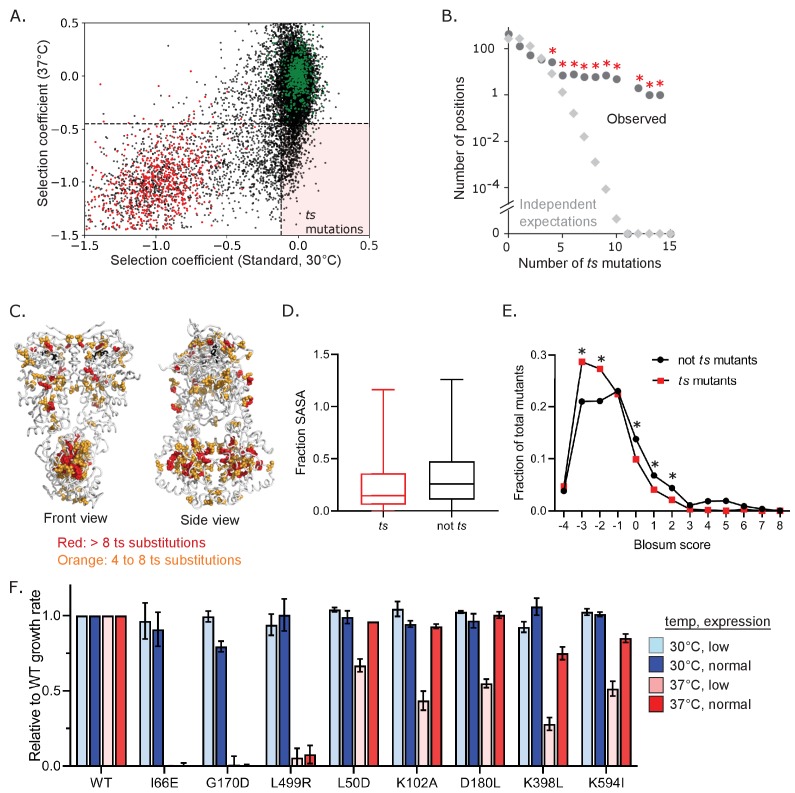
Abundance and mechanism of temperature-sensitive (ts) mutations in Hsp90.(A) Ts variants were identified that supported WT-like growth at 30°C, but were null-like at 37°C in bulk competitions. WT synonyms are shown in green and stops in red. The horizonal dashed line corresponds to y = −0.47, the upper limit of stops at 37°C and the vertical dashed line corresponds to x = −0.11, the lower limit of WT synonyms in standard conditions. The pink-shaded quadrant highlights ts mutations. All ts mutants are listed in Figure 4—source data 1. (B) Distribution of the number of observed ts mutations at the same positions of Hsp90 (●) is much greater than expected if they had occurred independently (◊). Independent expectations were calculated as the probability of the stated number of mutations occurring at the same position by chance. * Indicates observations that were significantly (p<0.01) greater than independent expectations based on random simulations and one-tailed t-tests. (C) Mapping positions with multiple ts variants onto Hsp90 structure. ATP is shown in black. (D) Solvent accessible surface area (SASA) of ts mutants compared to non-ts mutants. A two sample KS test showed significant differences in distributions (N = 663, 11762, p<0.0001, D = 0.1735) (E) Amino acid similarity to the wild type was estimated as the Blosum score (Henikoff and Henikoff, 1992) for ts and non-ts variants. A two-proportion z-test was performed on each pair for each Blosum score and their p-values were adjusted using Benjamini-Hochberg adaptive step-up procedure. * Indicates p<0.05 F. Growth rate of a panel of individual Hsp90 ts variants analyzed in isolation.Figure 4—source data 1.List of all temperature-sensitive mutants and associated selection coefficients.Ts mutants were defined as variants with selection coefficients within the distribution of wild-type synonyms in standard conditions and that of stop codons at 37°C.